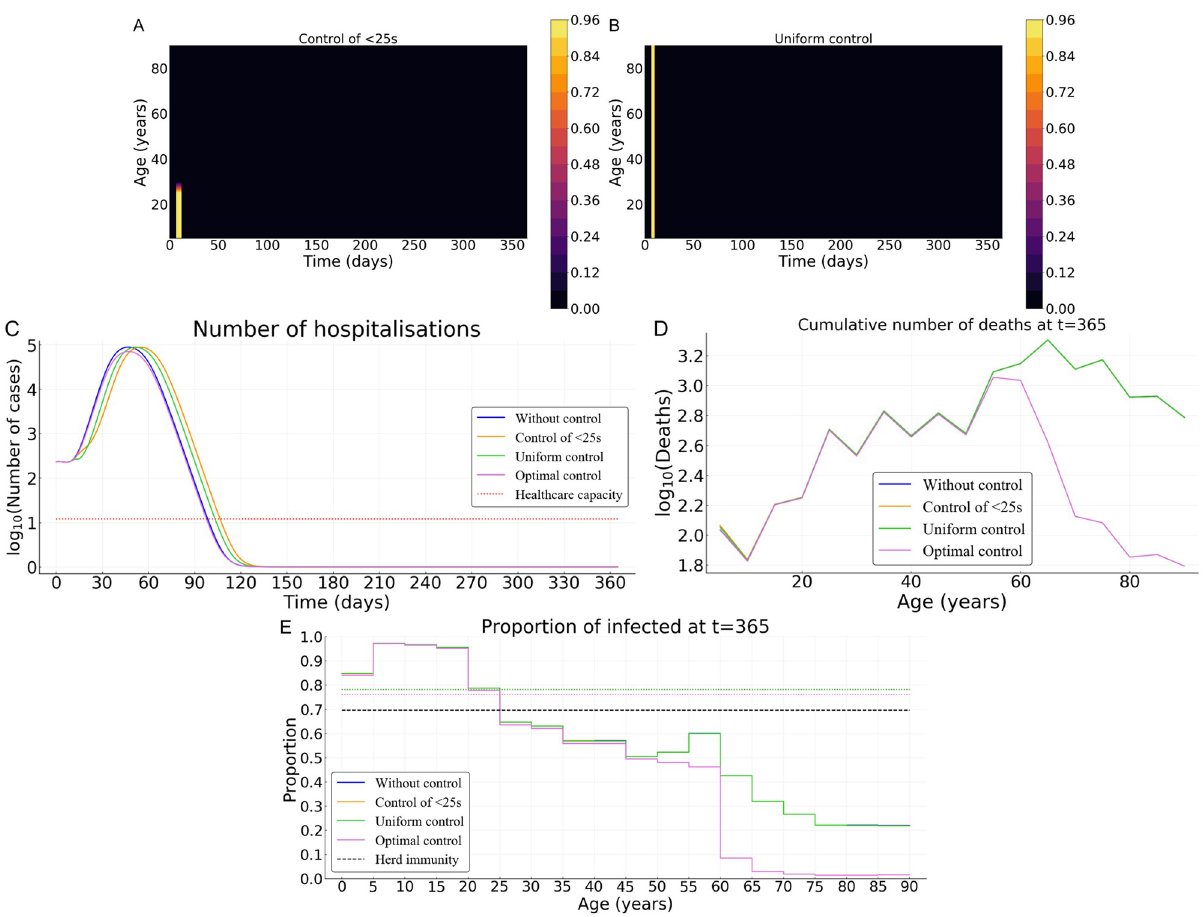
Fig 8. Comparing optimal control with uniform control of the whole population or over its younger fraction in Burkina Faso. (A) Illustration of the control over the young population and (B) uniform control of the whole population. (C) Number of hospitalizations. (D) Cumulative deaths per age at final time T = 365 days. (E) Age distribution of the proportions of the population that have been infected before one year. Here, we assume B � = 10 3 and p =